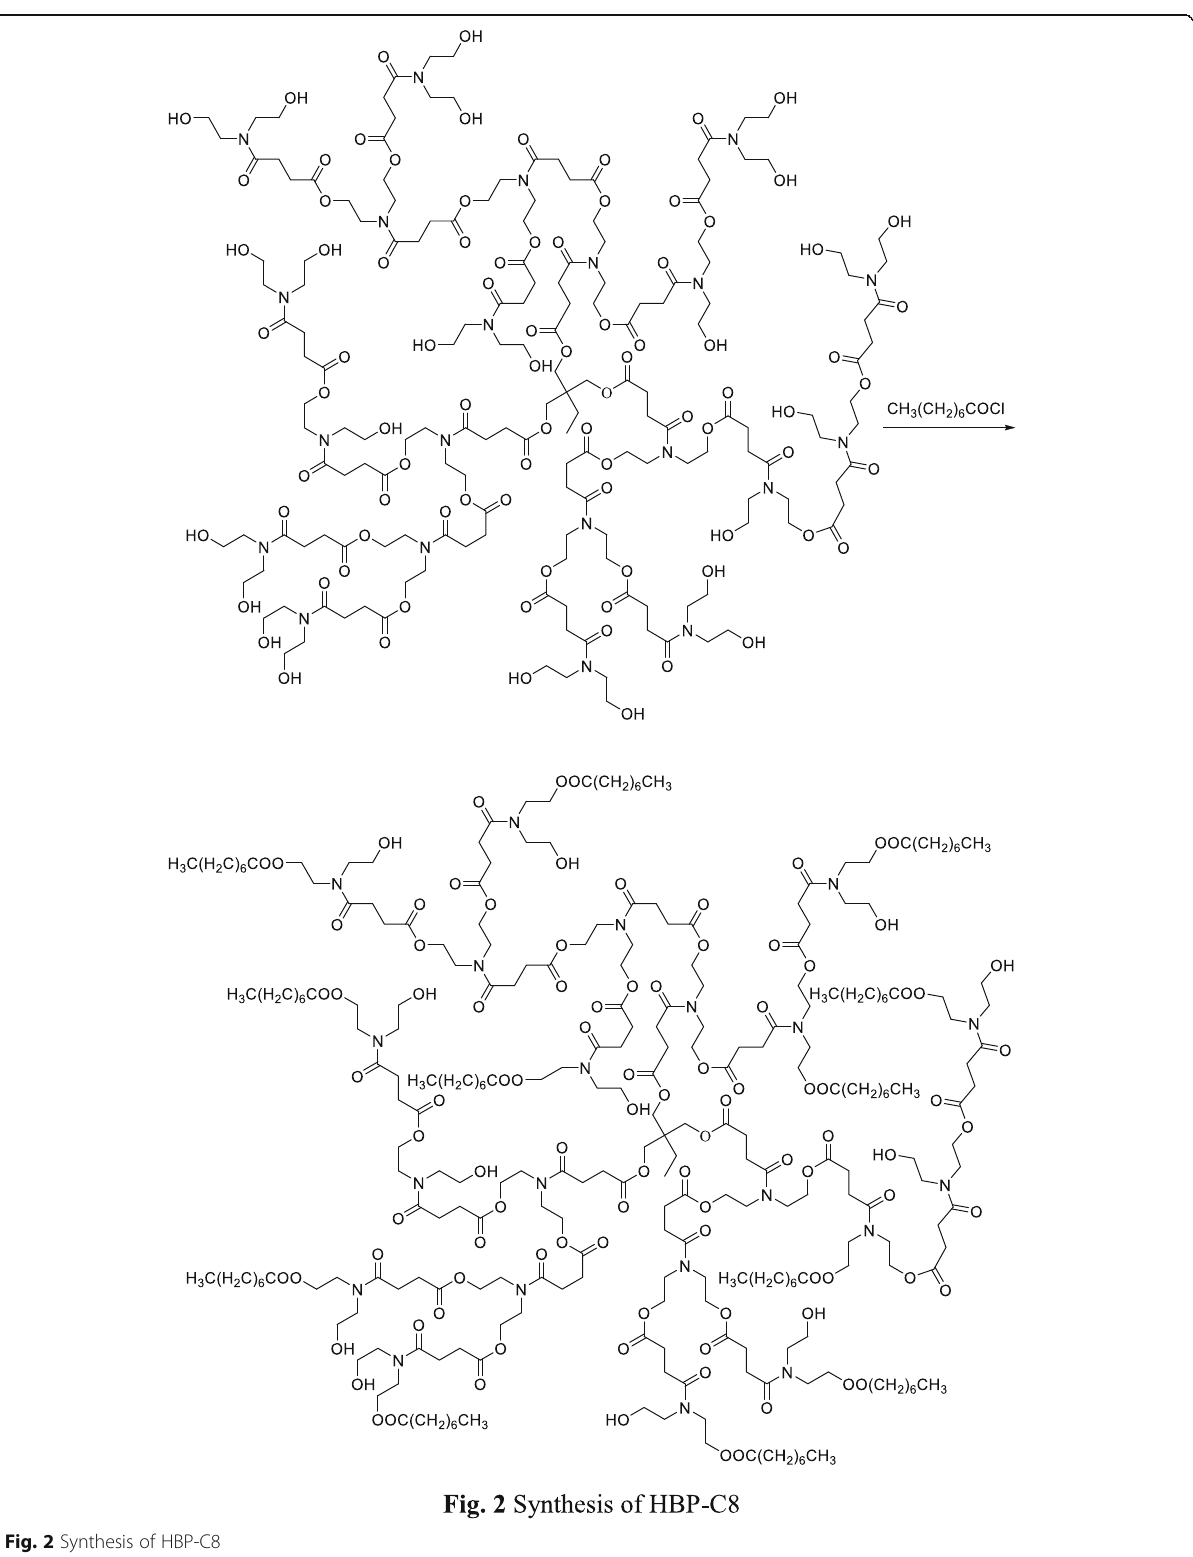
Fig. 2 Synthesis of